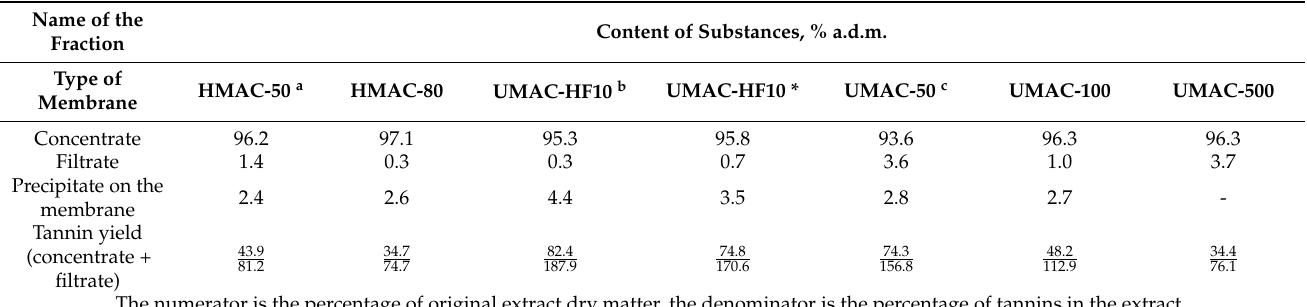
Content of Substances, % a.d.m.